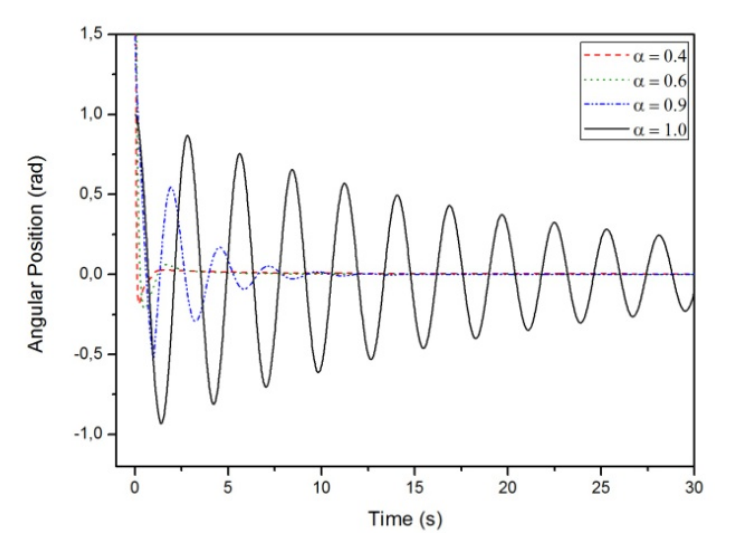
Figure 10. Time history (values of α ≤ 1).